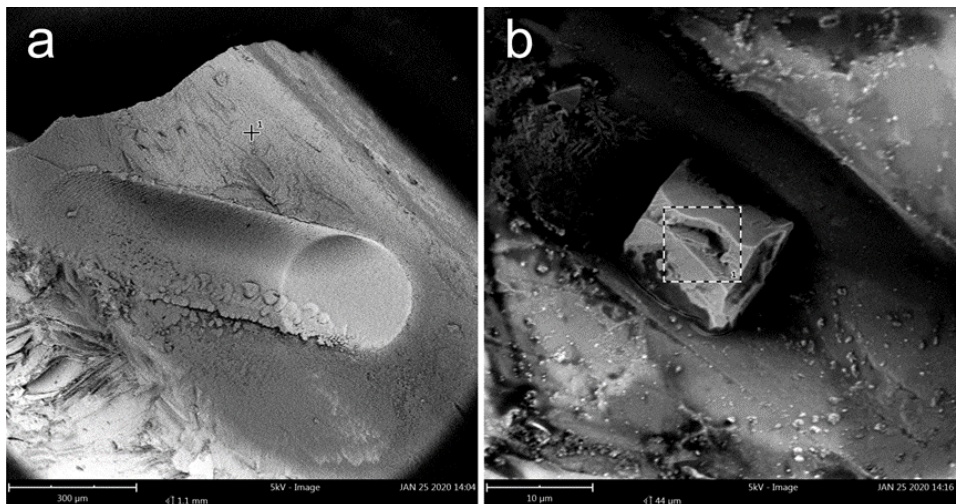
Figure 2. Back-scatter electron images of emeralds from Madagascar. ( a ) Surface of a Malagasy emerald with a 100 µm raster pit. Note textural variations on the surface of the emerald; EDS mapping suggests broad homogeneity across the shown image; ( b ) solid inclusions occur in emeralds, along with fluid inclusions. For example, this sylvite grain within a fracture in a Malagasy emerald.